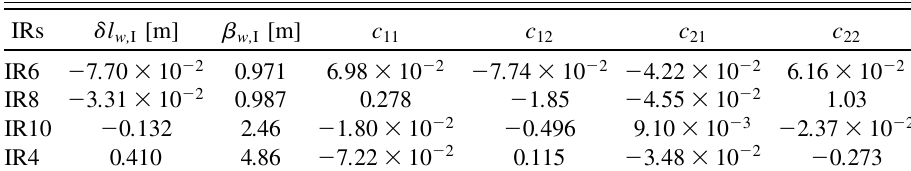
TABLE III. Optics parameters at (cid:1)